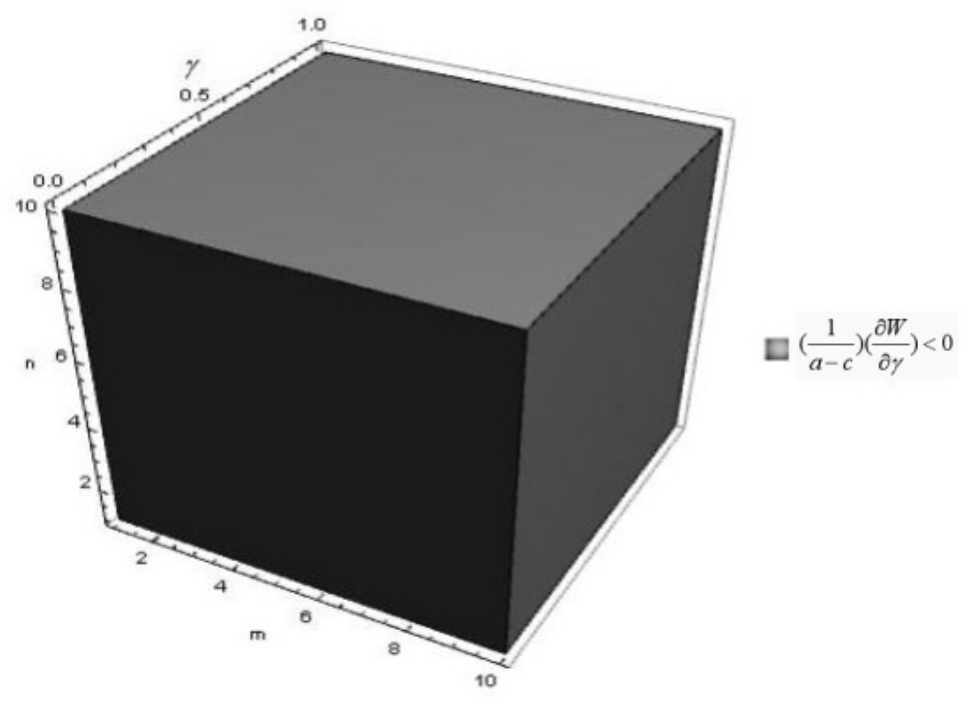
(cid:3105)(cid:3024) Figure 5. (cid:2869) for 𝑛 ∈ [1,10] , 𝑚 ∈ [1,10] and 𝛾 ∈ [0,1] . Figure 5. Figure 5. (a-c) (cid:3105)(cid:3082) The shaded region in Figure 5 shows The shaded region in Figure 5 shows 1 The shaded region in Figure 5 shows higher γ reduces welfare. higher 𝛾 reduces